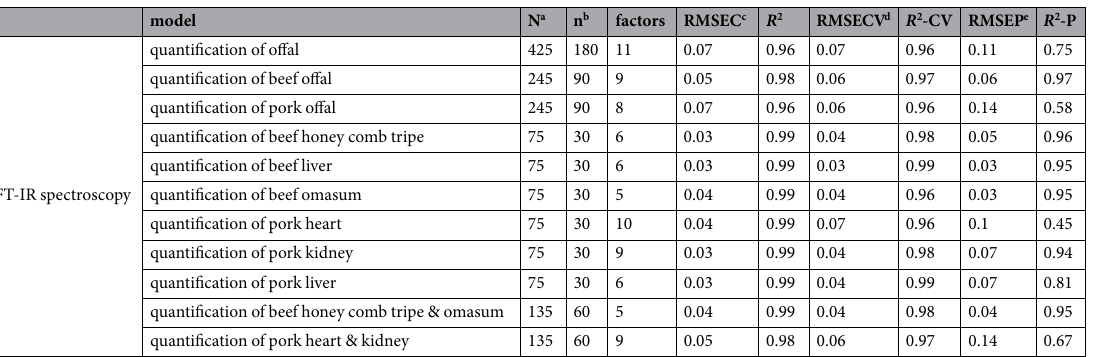
Table 4. Partial least squares regression (PLSR) models for the quantification of offal using FT-IR spectroscopies. a N, number of spectra for calibration. b n, number of spectra for prediction. c RMSEC, root mean squares error of calibration. d RMSECV, root mean squares error of cross-validation (9-fold). e RMSEP, root mean squares error of